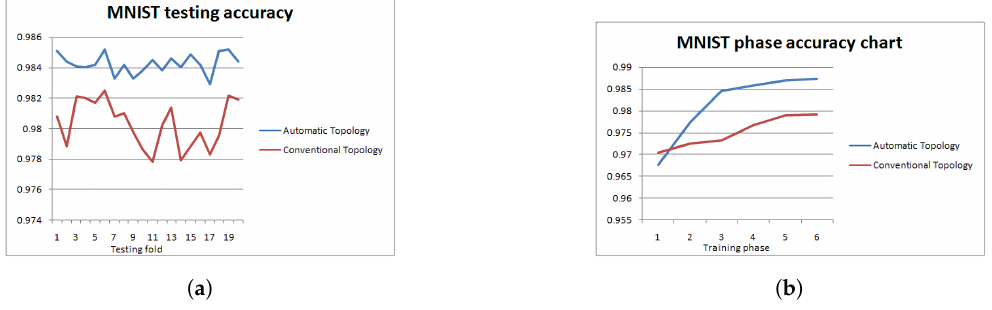
Figure 11. ( a ) MNIST Testing accuracy variation over random independent runs of the optimized and the conventional NN; ( b ) MNIST Testing accuracy every five-epoch tranining (1 phase) for the optimized and the conventional